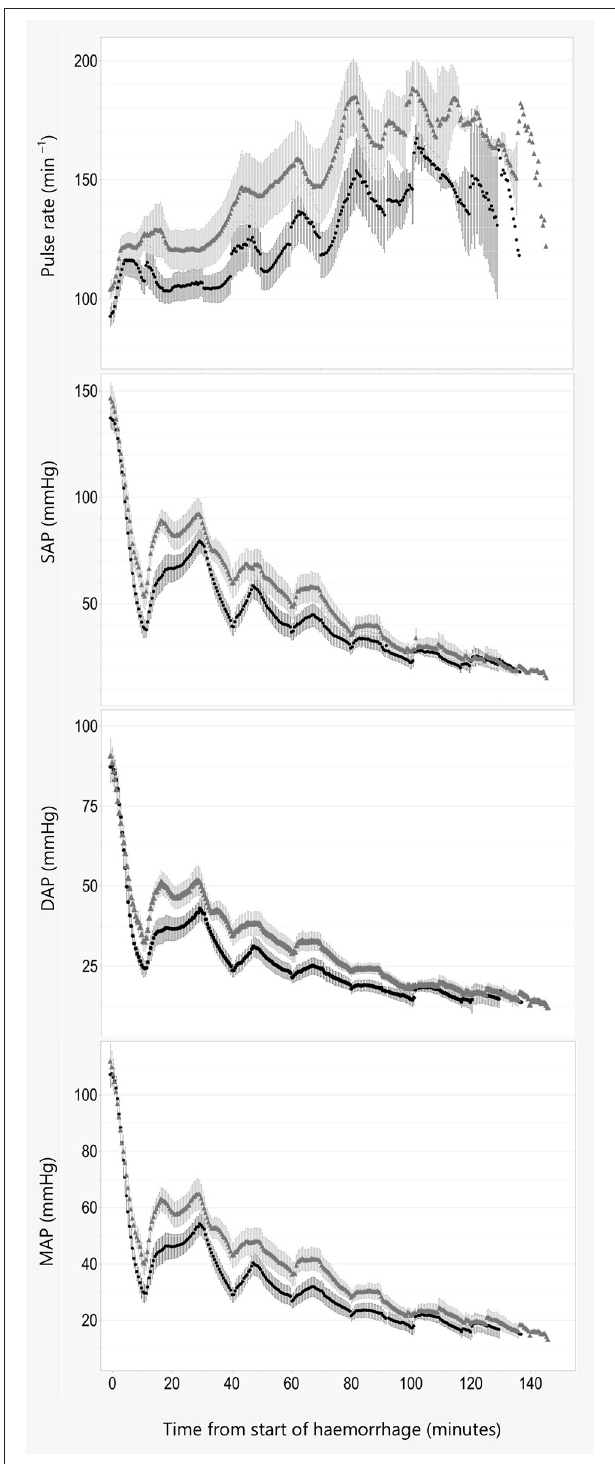
FIGURE 3 | Pulse rate and blood pressure. Data are plotted against time in minutes from start of hemorrhage. Pulse rate, systolic (SAP), diastolic (DAP), and mean (MAP) arterial blood pressure are illustrated as Mean ± SEM, and black line and filled circles represent pigs anesthetized with propofol 8mg kg − 1 h − 1 . Gray line and triangles represent pigs anesthetized with alfaxalone 5mg kg − 1 h − 1 . In addition, all pigs were administered ketamine 5mg kg − 1 h − 1 and dexmedetomidine 4 µ g kg − 1 h − 1